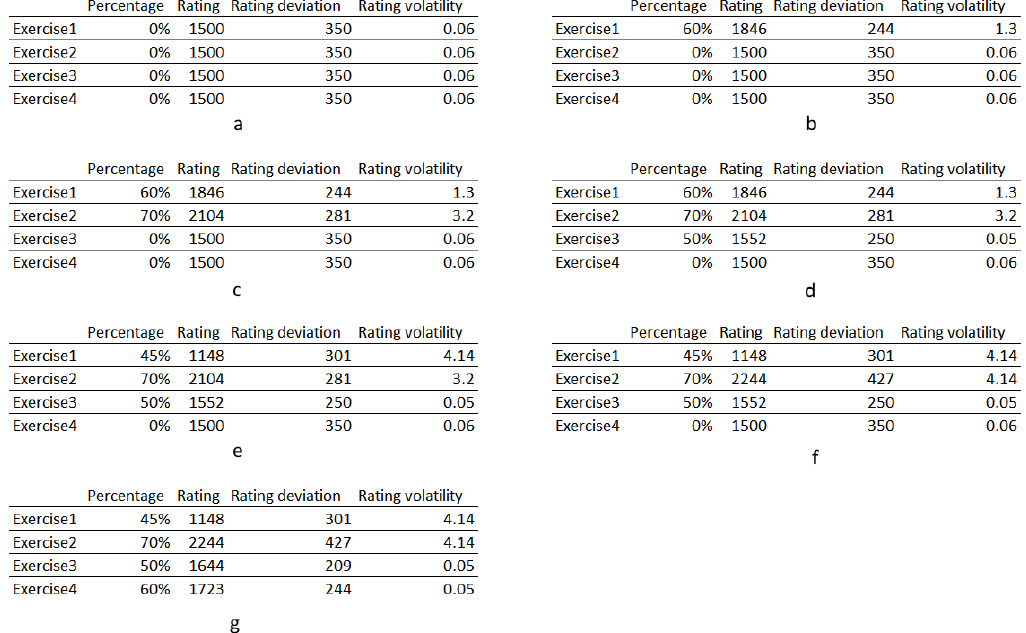
Figure 2. The outcome of the rating process and the self-correcting exercise suggestion. The fields are: the percentage of completeness, the exercise rating (1500 is the base value), the rating deviation (the confidence interval), and the rating volatility (the degree of expected fluctuation of the